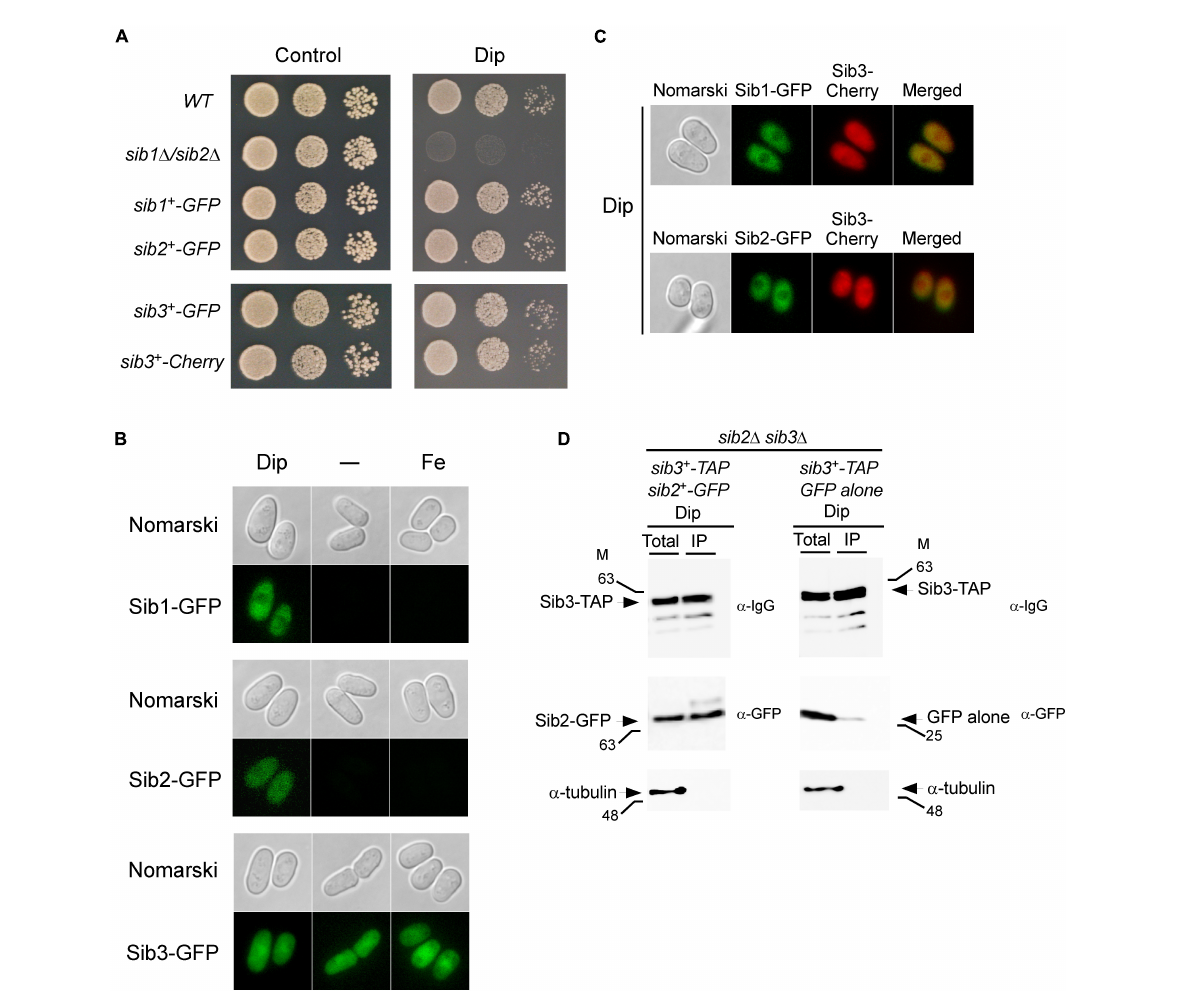
FIGURE5 Localization of Sib1, Sib2 and Sib3 proteins in S. pombe . (A) Strains in which the GFP coding sequence was directly integrated at the chromosomal locus of sib1 + , sib2 + , or sib3 + were created and termed sib1 + -GFP, sib2 + -GFP, and sib3 + -GFP strains, respectively. In the case of sib3 + , an identical approach was performed using the Cherry coding sequence, thereby creating the sib3 + -Cherry strain. Wild-type (WT), sib1 (cid:49) sib2 (cid:49) , sib1 + -GFP, sib2 + -GFP, sib3 + -GFP, and sib3 + -Cherry strains were grown to the logarithmic phase under non-selective growth conditions and spotted in serial dilutions onto YES medium without Dip (control) or with Dip (140 µ M). (B) Strains expressing sib1 + -GFP , sib2 + -GFP , and sib3 + -GFP alleles under the control of their own promoters were untreated (-) or treated with Dip (250 µ M) or FeCl 3 (100 µ M) for 90 min. Cells were analyzed by fluorescence microscopy for the presence of GFP-dependent fluorescence signals ( bottom of each pair of panels ). Nomarski optics ( top of each pair of panels ) was used for examining cell morphologies. (C) Strains co-expressing Sib3-Cherry in combination with Sib1-GFP or Sib2-GFP were incubated in the presence of Dip (250 µ M) for 90 min. Fluorescence signals of Sib3-Cherry co-expressed with Sib1-GFP or Sib2-GFP were observed by fluorescence microscopy ( middle panels ). Merged images of co-expressed fluorescent proteins are shown in the far right panels . Cell morphology was examined by Nomarski optics in the far left panels . Results of microscopy are representative of five independent experiments. (D) sib2 (cid:49) sib3 (cid:49) cells co-expressing GFP-tagged Sib2 and TAP-tagged Sib3 or GFP alone and TAP-tagged Sib3 were grown to the mid-logarithmic phase and incubated in the presence of Dip (250 µ M) for 90 min. Whole cell extracts (Total) were incubated with IgG-Sepharose beads. The immunoprecipitated fractions (IP) were analyzed by immunoblot assays using anti-mouse IgG ( α -IgG), anti-GFP ( α -GFP) and anti- α -tubulin antibodies. Aliquots of whole cell extracts (Total) were probed with the same antibodies to ascertain the presence of epitope-tagged proteins prior to incubation with beads. As an additional control, aliquots of total cell lysates and bound fractions were assayed using an anti- α -tubulin antibody. The positions of the molecular weight standards (in kDa) are indicated on the left and right sides of the